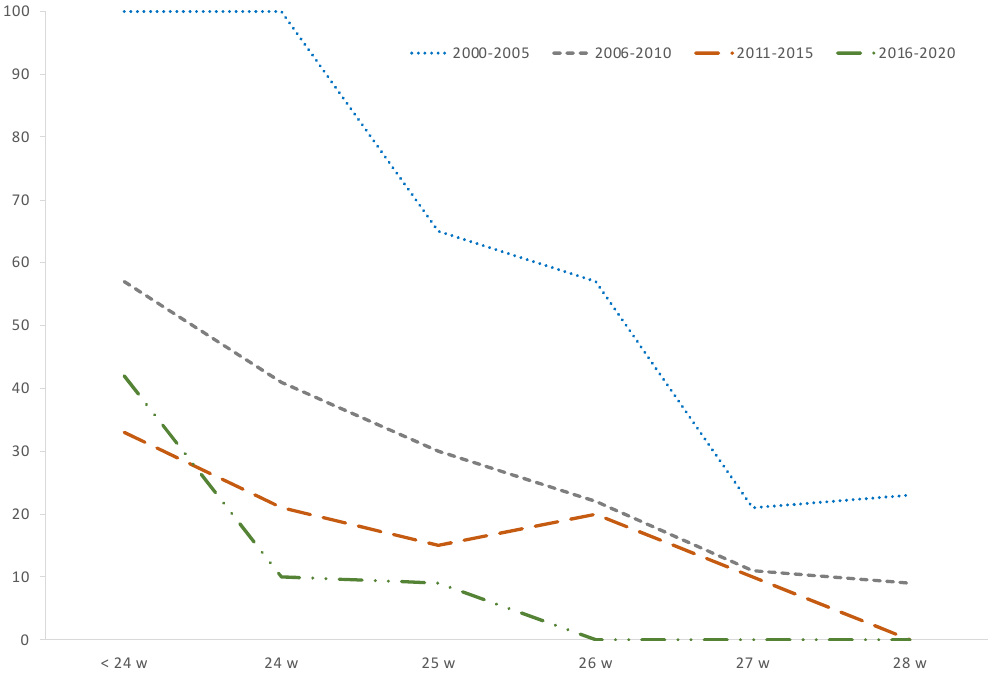
Figure 8. Perinatal mortality rate according to gestational age at PPROM diagnosis. The duration of the latency period from diagnosis until delivery correlated significantly with perinatal mortality (Pearson’s coefficient 0.234; p < 0.0001). However, the perinatal mortality in the sample was high regardless g.a. at diagnosis of PPROM, reaching 46.2% (75/162) in the group of previable pregnancies (Figure 9), and 37.8 (25/66), 25.3% (21/83), 22.6% (17/75), 10.6% (8/75) and 7.75% (9/116) in cases of PPROM at 24, 25, 26, 27, and 28 weeks, respectively.